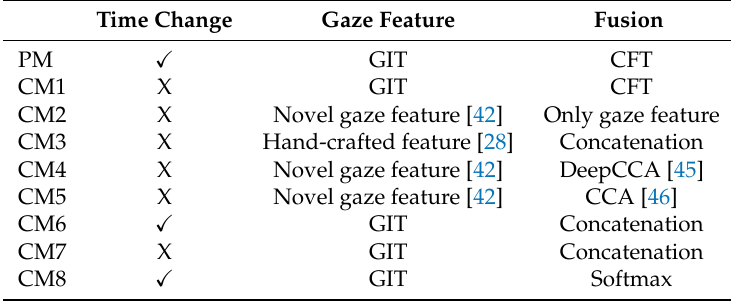
Table 1. The difference of the proposed method (PM) and comparative methods (CMs). The marks ’ (cid:88) ’ and ’X’ mean that the corresponding method considers or does not consider the time change. Moreover, “Softmax” means that we applied the softmax function to the outputs of several classifiers and obtained probabilities. Then, classification was performed based on the value obtained by multiplying these probabilities. Furthermore, “Hand-crafted feature” means that CM3 extracted hand-crafted visual features such as Gabor filter-based and Sobel filter-based visual features from images obtained by superimposing original images and fixation maps. Time Change Gaze Feature